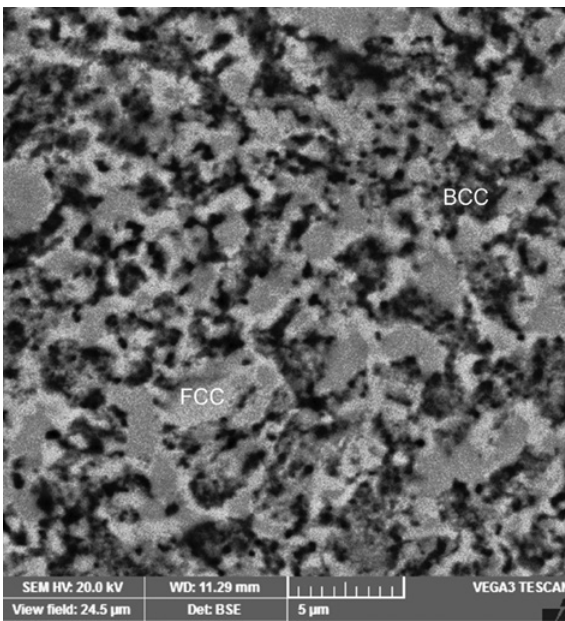
Figure 4: SEM-BSE image of AlMgNiCrTi HEA after SPS at 800 ° C.